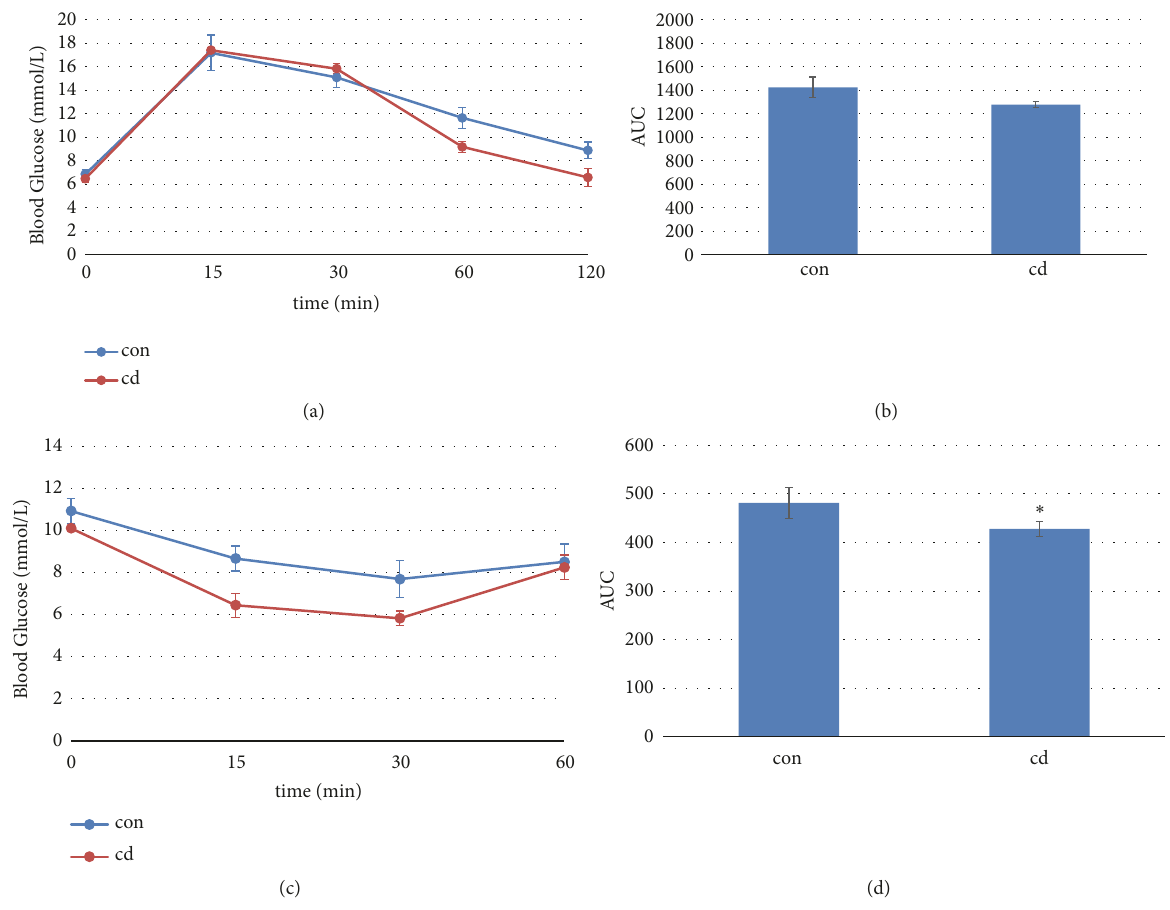
Figure 4: Effects of chronic Cd exposure on the intraperitoneal glucose tolerance test (IPGTT: (a) and (b)) and the intraperitoneal insulin tolerancetest(IPITT: (c)and (d))in maleC57BL/6mice.Data aremean ± SEM (n=5/group). ∗ Significantly differentfrom conand Cd groups, at P <